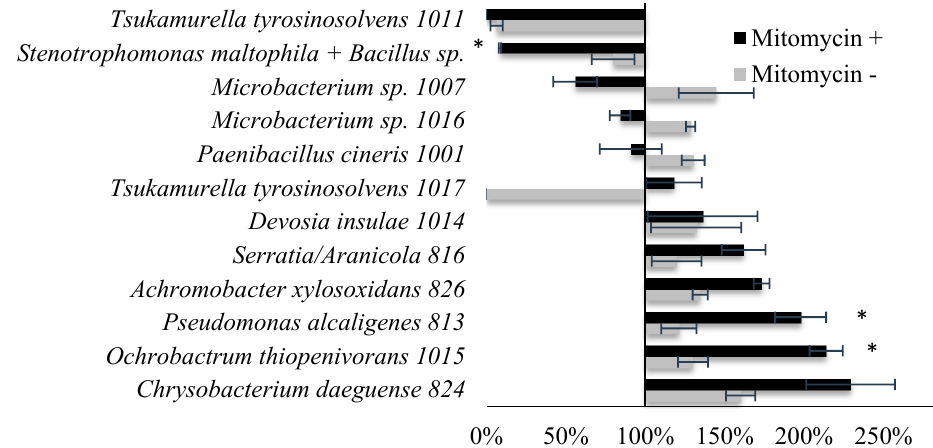
Figure 4. Mobility index of rotifers treated with phage product of bacterial culture (mitomycin+) and bacterial culture (mitomycin − ) calculated in comparison to the control (treated only with TSB (tryptic soy broth) medium; asterisks (*) indicate statistically significant differences between mitomycin − and mitomycin+ treatments based on a t -test ( p ≤ 0.05).